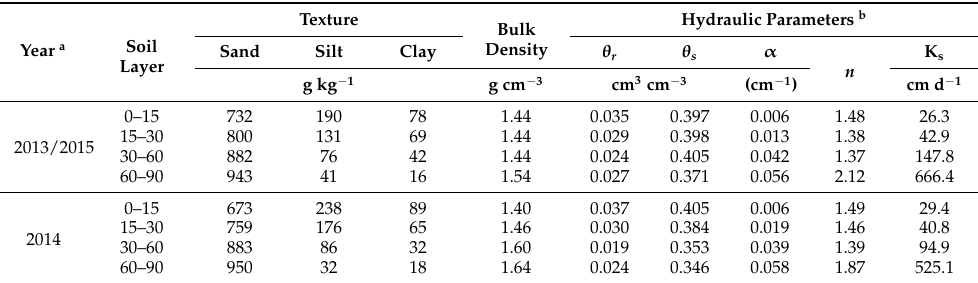
Table 1. Soil particle size and hydraulic parameters of the soil profile in this